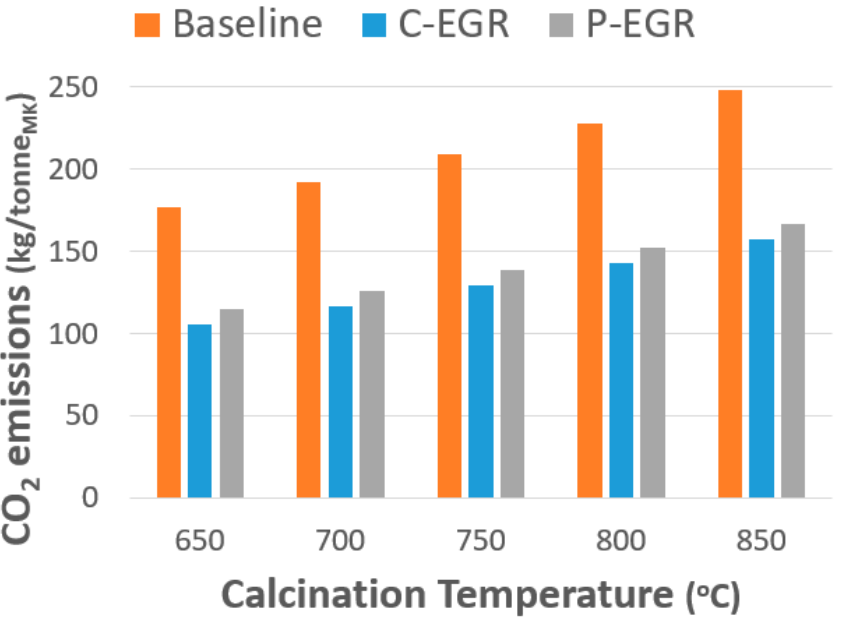
Figure 6. Calculated MK production process CO 2 emissions (kg/tonne MK ). Impact of calcination temperature. (Fuel: NG; reference moisture content of kaolinite: 15%